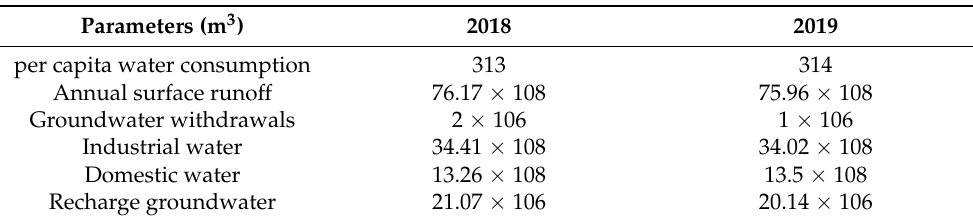
Table 3. Overview of water resources in Shanghai in 2018 and 2019.